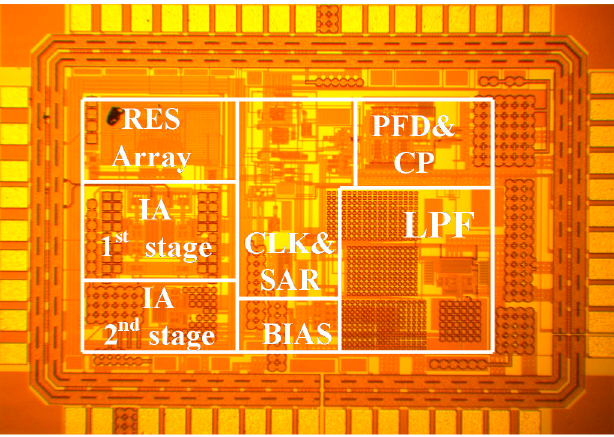
Figure 19. Chip micrograph of the chopper IA with an ATL. Table 2. Performance Summary of the Chopper IA.